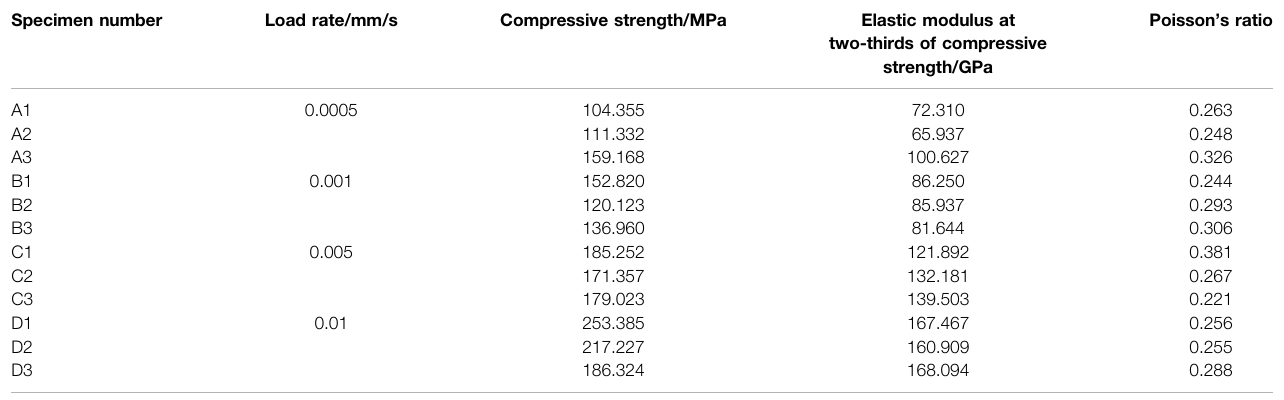
TABLE 1 | Test parameters of specimens under different loading rates.